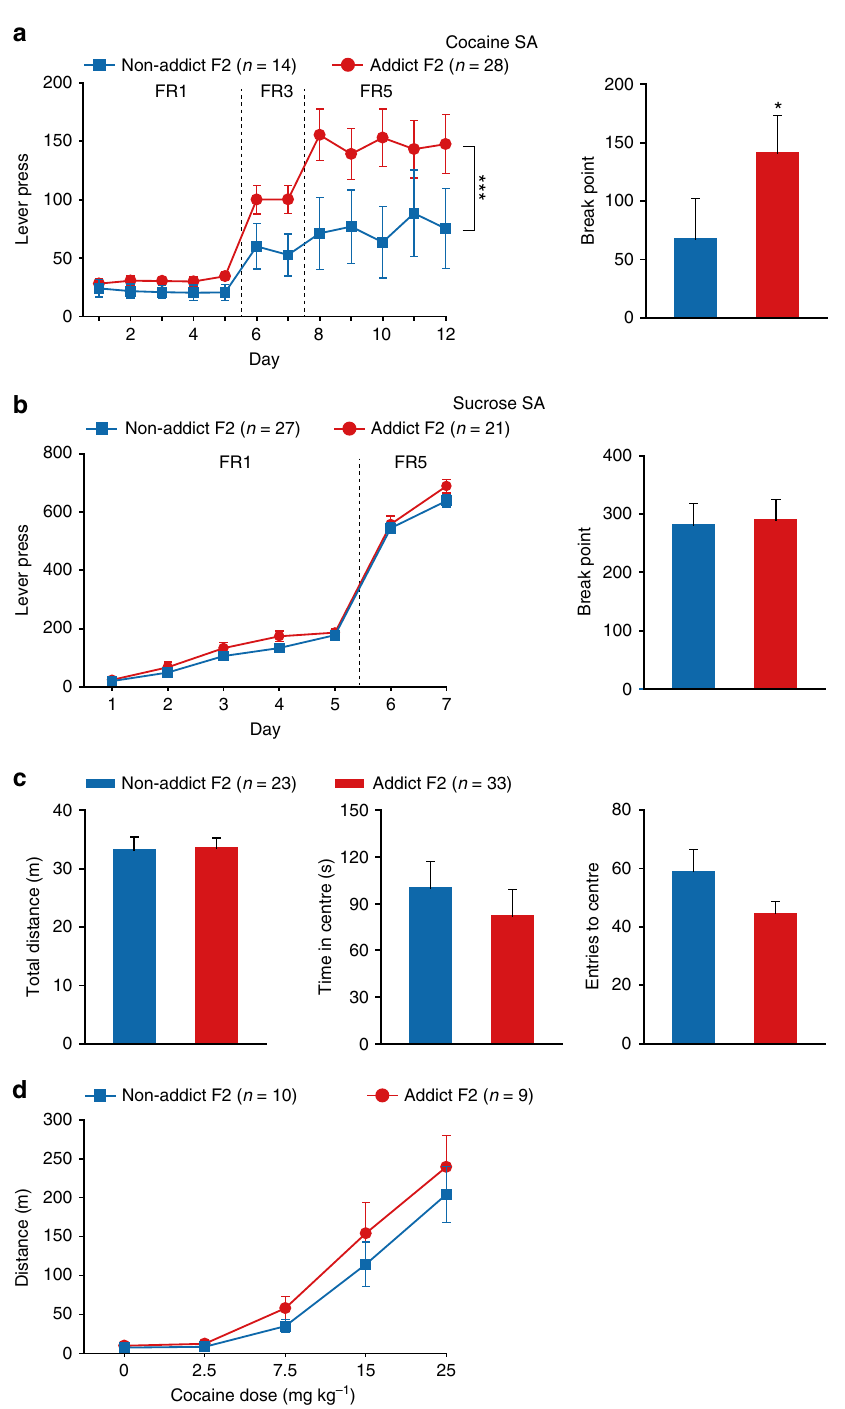
Figure 3 | Addict F2 displayed higher responding to cocaine-induced reinforcement than Non-addict F2. ( a ) Addict F2 rats displayed higher cocaine consumption and motivation than Non-addict F2. Lever press, Group (cid:3) FR, MMRM, w 2 (2) ¼ 28.63, P o 0.001; Group, P ¼ 0.052; FR5, *** P o 0.001, Non- addict F2 versus Addict F2. Break point, Mann–Whitney Rank-Sum Test, Z ¼ 2.513, * P ¼ 0.013. Non-addict F2, n ¼ 14; Addict F2, n ¼ 28. ( b ) Sucrose self- administration. Lever press, Group (cid:3) FR, MMRM, w 2 (1) ¼ 0.29, P ¼ 0.588. Break point, Mann–Whitney Rank-Sum Test, Z ¼ 0.783, P ¼ 0.433. Non-addict F2, n ¼ 27; Addict F2, n ¼ 21. ( c ) Open field test. Total distance, Student’s t -test, t (54) ¼ 0.0964, P ¼ 0.924. Time in centre, Student’s t- test, t (54) ¼ 0.729, P ¼ 0.469. Entries to centre, Student’s t- test, t (54) ¼ (cid:2) 1.796, P ¼ 0.0781. Non-addict F2, n ¼ 23; Addict F2, n ¼ 33. ( d ) Cocaine-induced locomotor activity. Two-way RM ANOVA, F group (cid:3) day (4, 68) ¼ 1.170, P ¼ 0.295. Non-addict F2, n ¼ 10; Addict F2, n ¼ 9. Data are expressed as mean ± s.e.m. fathers (Non-addict-SA, Non-addict-Yoke, Addict-SA, and Non-addict groups was not different. These data indicate that Addict-Yoke rats) showed cocaine dose-dependent elevation of paternal cocaine experience induces BDNF elevation in F1 BDNF level, compared with F1 offspring of Saline-SA group. offspring, and this is correlated with the amount of cocaine However, BDNF level between SA and yoked rats from Addict or taken by F0 fathers, not motivation for reinforcement. NATURE COMMUNICATIONS|8:15527|DOI: